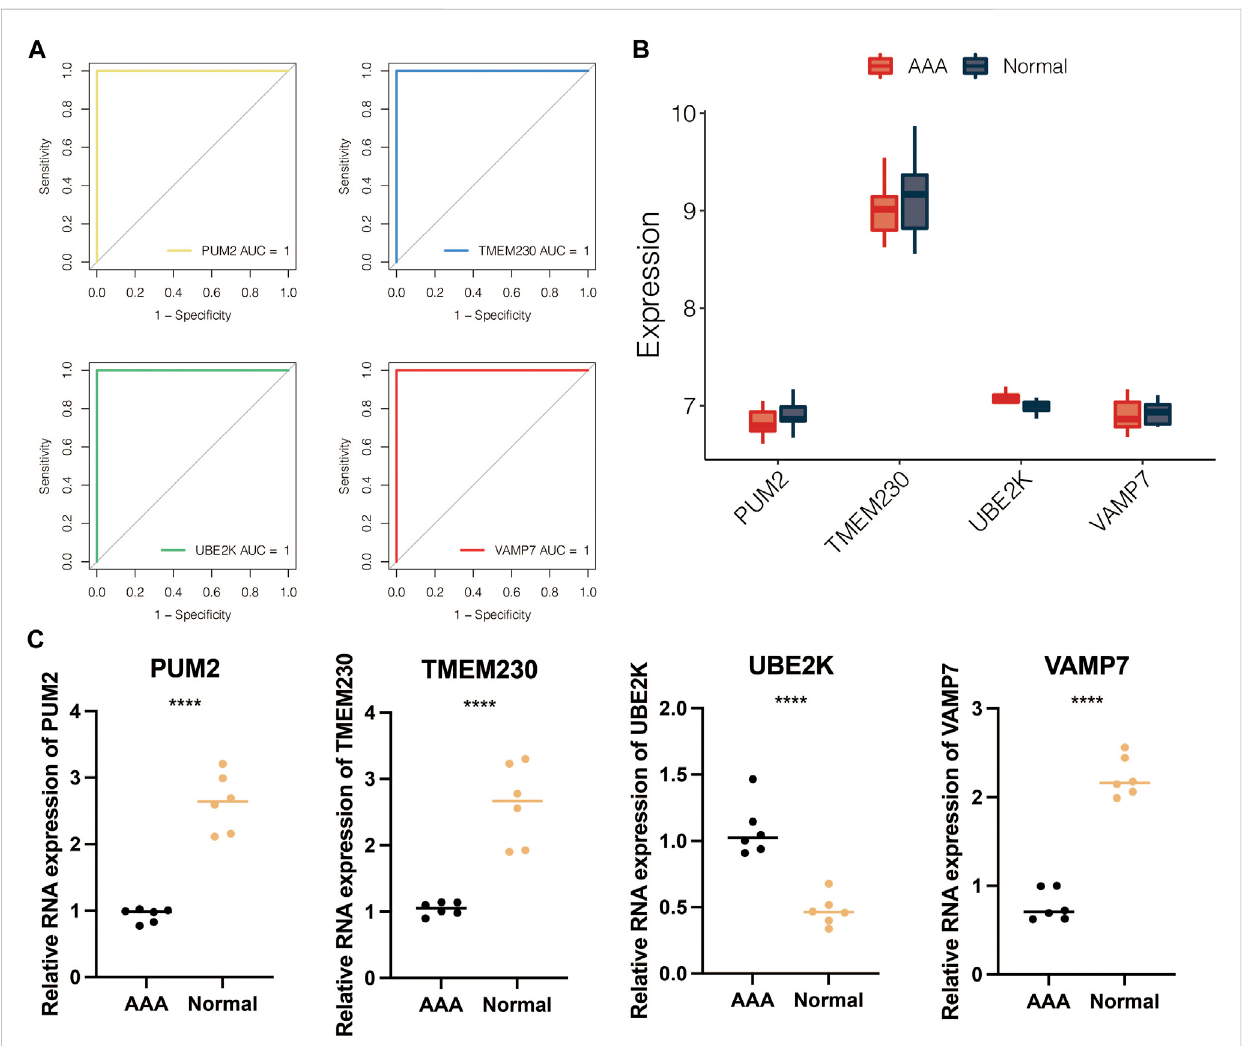
FIGURE 7 Validation of four model genes. (A) ROC curves of four model genes in predicting the AAA-related clusters in GSE98278. (B) The expression of four model genes in AAA and normal samples in GSE47472. (C) The expression of four model genes in AAA and normal samples by qRT-PCR